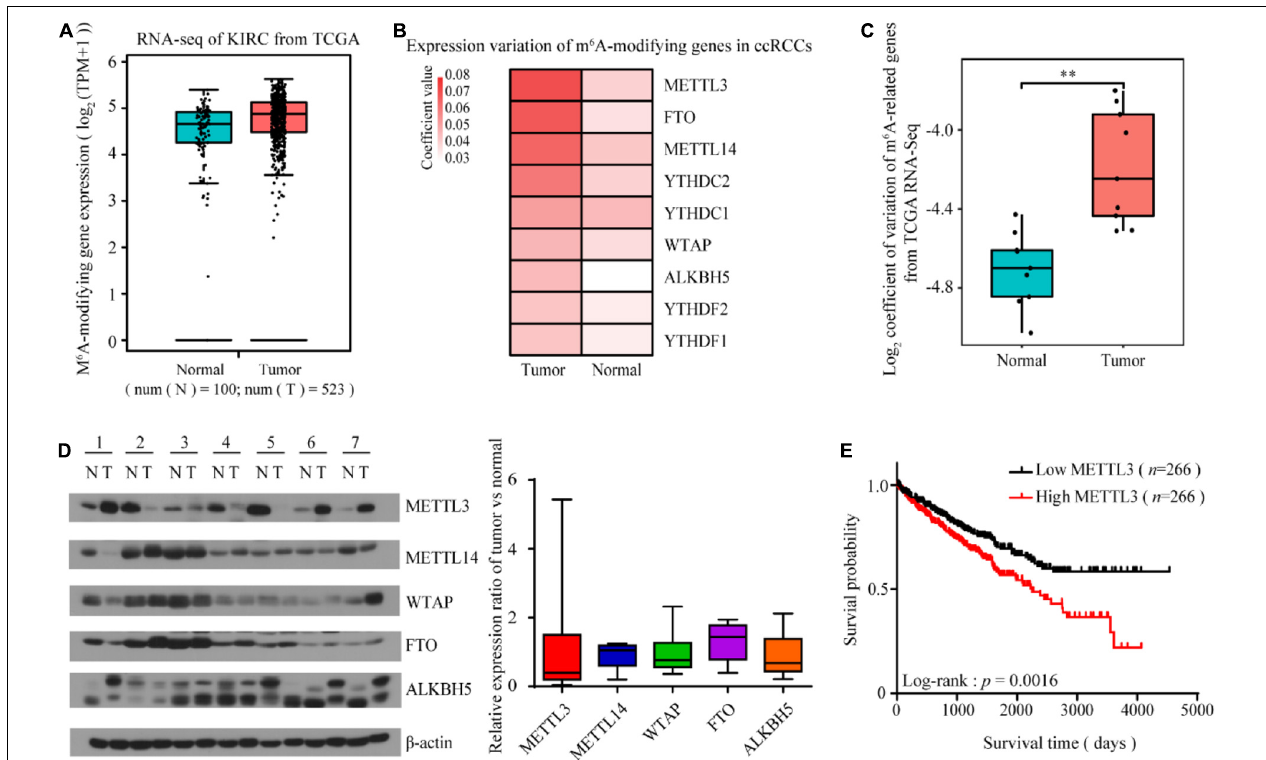
FIGURE 1 | The expression variability of m 6 A-modifying genes is increased in ccRCC, especially METTL3. (A) The mean expression of the m 6 A-modifying gene set was not significantly changed in the ccRCC tumor tissues compared to the normal tissues from TCGA Data Portal. (B,C) The coefficient of expression variation of m 6 A-modifying genes in the ccRCC tumor tissues compared to the normal tissues (unpaired two samples Wilcoxon test). (D) The protein levels of m 6 A-modifying proteins in seven paired tumor tissues and matched normal tissues from ccRCC patients was determined by western blots (left). β -actin was used as a loading control. The relative expression ratio of m 6 A-modifying proteins between tumors and normal tissues after normalization to β -actin expression (right). (E) Kaplan-Meier survival curves using TCGA Data Portal showed that the expression level of METTL3 can predict the clinical outcome of ccRCC patients. p -values were calculated by the log-rank test. n , the number of cases. ** P <